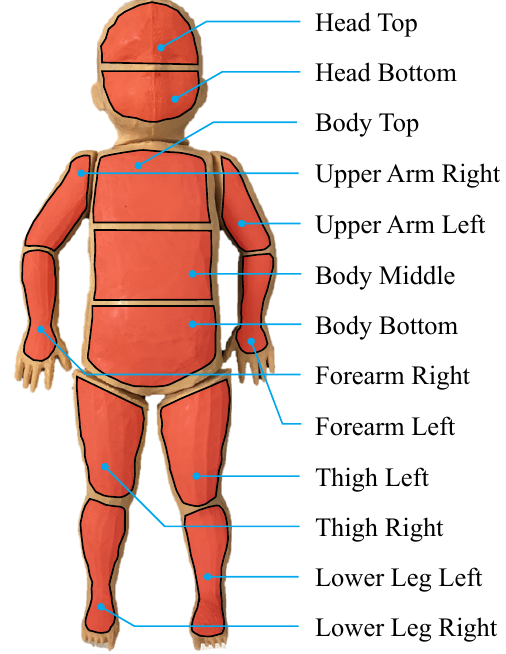
Figure 1. Individual heating regions adapted from [23]. While the head and the limbs were divided into two heatable areas, the torso was subdivided into three